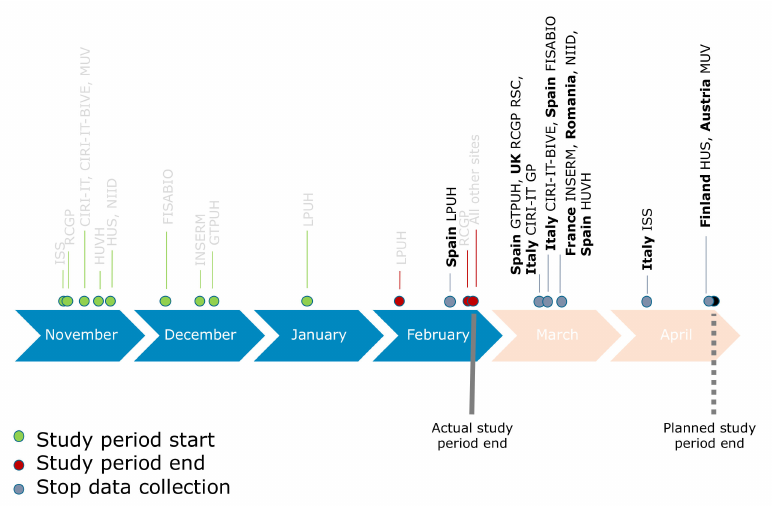
Figure 2. New study period adjusted due to COVID-19 pandemic. Study period for main analysis was considered until 29 February 2020; sensitivity analysis considered data collected until 30 April 2020. However, the actual study period end (defined as first week of two subsequent weeks of no influenza cases detected) was in week 12 of 2020 at all DRIVE sites, indicating there was no more influenza circulating even at the sites that did still collect data beyond end of February. Only showing TND